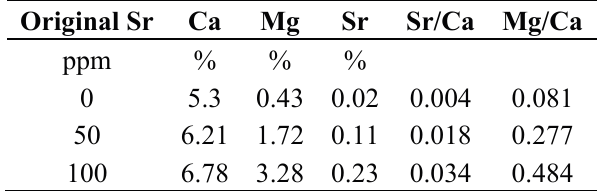
Table 2. SEM-EDS quantifications of atomic ratios of Ca, Mg and Sr elements in coccoliths of E. huxleyi in the presence of different Sr concentrations in original culture